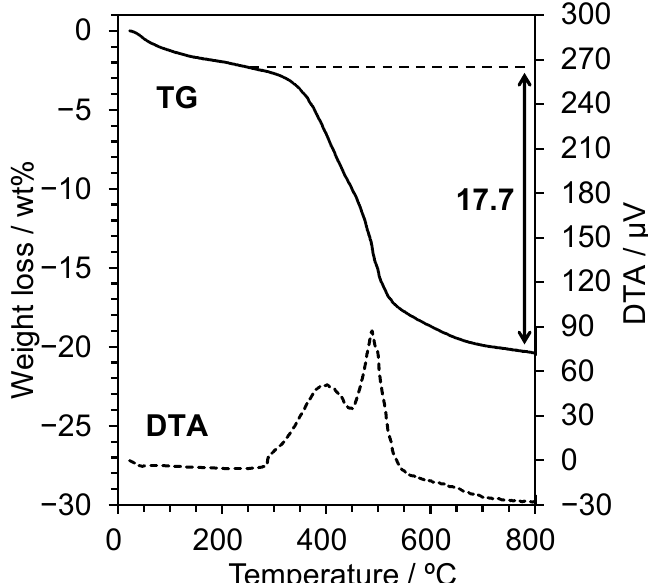
Figure 4. TG-DTA analysis for as-synthesized AFX zeolite.